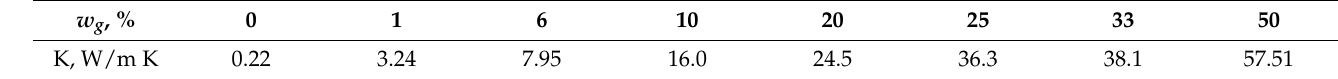
Table 6. Thermal conductivity of polymer-based samples with various graphene loading